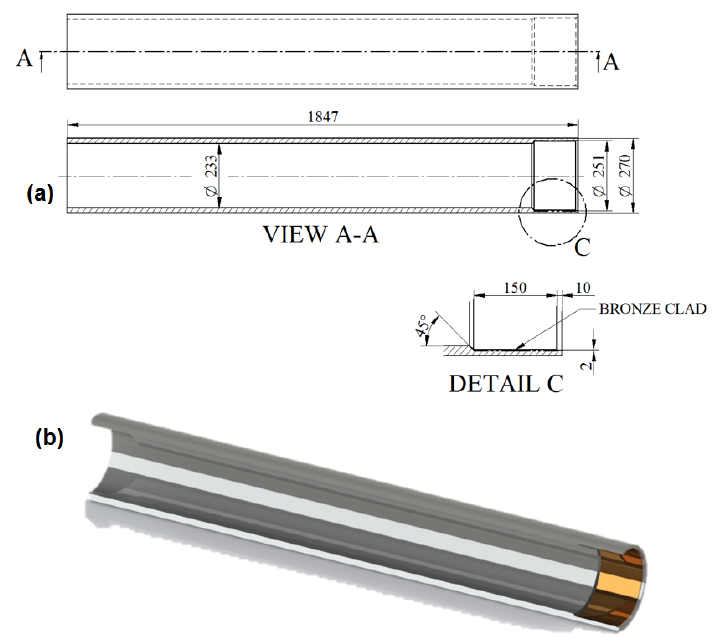
Figure 2. Steel bridge prop with bronze sliding bearing. ( a ) Bridge prop drawing; ( b ) Cross-section of 3D model—created in SolidWorks 2017 CAD software (Dassault Systèmes SOLIDWORKS Corp., MA, USA).